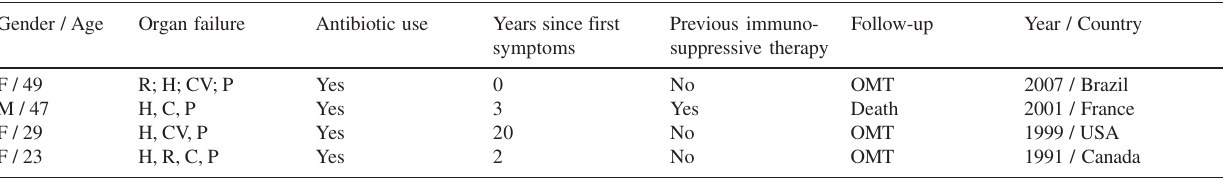
Table 2 - Previous case reports of adult-onset Still´s disease evolving with organ